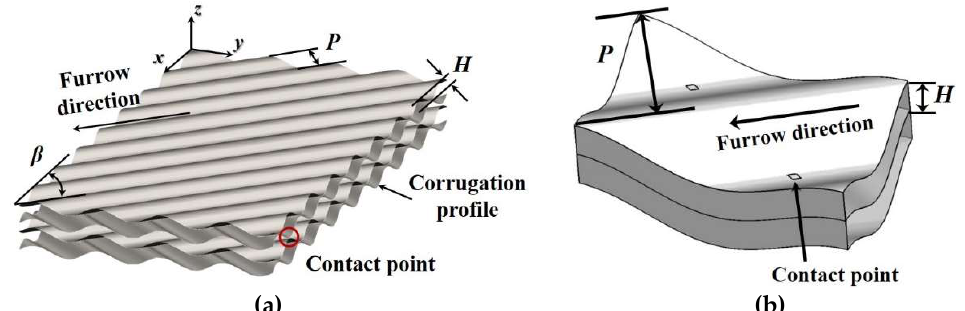
Figure 1. The configuration of the chevron shape of the plate heat exchanger: ( a ) partial plates and ( b ) a unitary cell repeated section with contact points in the flow channel.